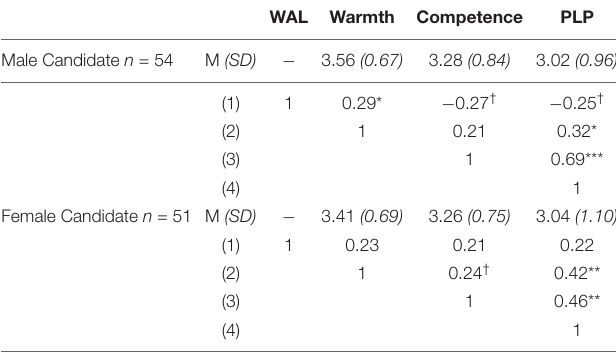
TABLE 5 | Study 3 descriptive statistics and